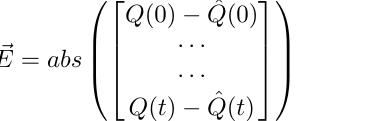
frequency can be found and the magnitude M is cal- culated using Equation